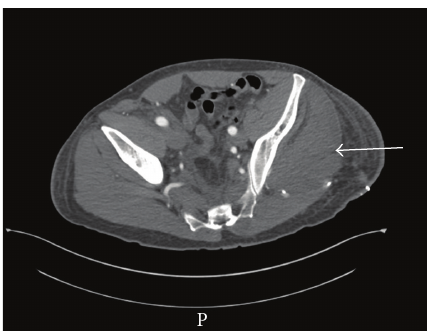
Figure 1: CT scan with IV contrast of the pelvis showing the swollen left gluteal region and the extravasation of contrast